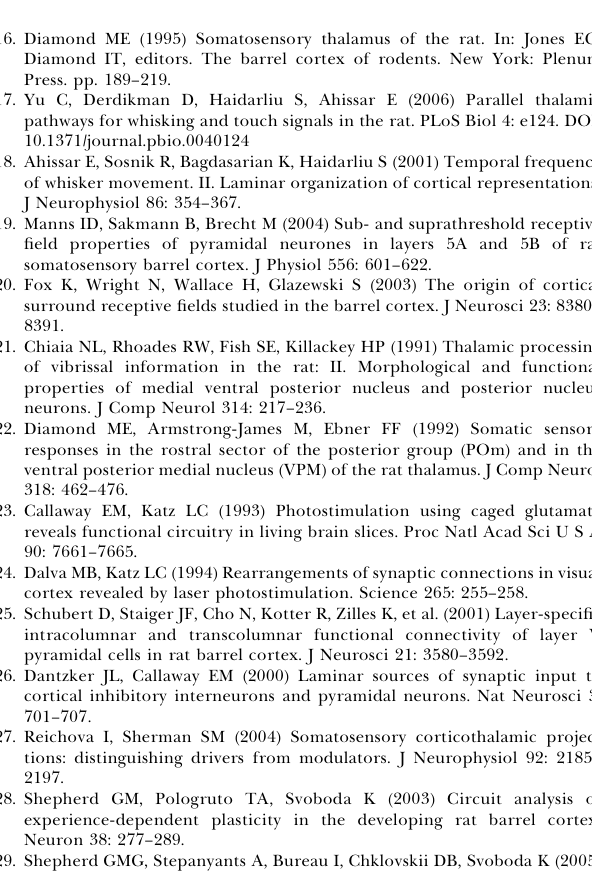
Figure S1. Excitation Profiles of L4 and L5A Cells (A) Average excitation profile of L4 cells located close to the L4/L5A boundary. Photostimulation over L5A rarely elicited APs in these cells. Pixel values encode the number of APs in a 100-ms window after photostimulation. (B) Average excitation profile of L5A cells located close to the L4/L5A boundary. These neurons were all pyramidal. Photostimulation over L4 readily excited these cells. Figure S2. Input Ratios for Groups of L2/3 Barrel Cells in the Same Slice (A) Schematic showing the regions of interest used in (B). (B) The ratios of input from different layers as a function of distance of L2 Barrel (closed circles) and L3 Barrel (open circles) cells from the pia. Groups of cells tested in the same slice are shown with symbols of the same colors. Found at DOI: 10.1371/journal.pbio.0040382.sg002 (445 KB EPS). Figure S3. Center of Mass of Synaptic Inputs (A) Schematic of the analysis shown in (B). The distance (d) between the soma (circle) and the center of mass (cross) of the L4 projections was measured for individual L3 cells. The center of mass is: R (synaptic input 3 lateral distance from soma)/ R (synaptic input). (B) Distance (d) between the center of mass of the L4 (green) and L5A (blue) projections, and the somata of L3 and L2 cells located above barrels and septa. Open circles are for individuals cells, closed circles are the averages 6 s.e.m. Found at DOI: 10.1371/journal.pbio.0040382.sg003 (520 KB EPS).